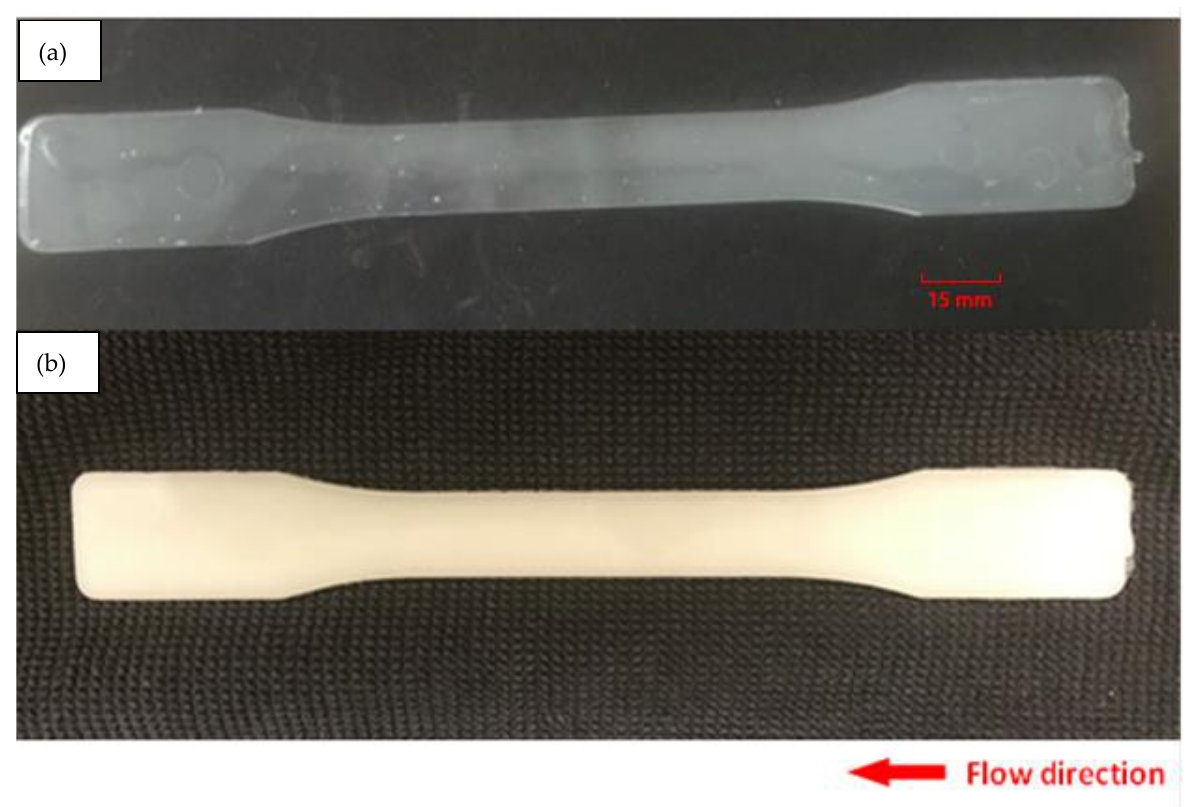
Figure 1. Injection molded sample: ( a ) neat PLA, ( b ) PLA-OA blend at 90 °C mold temperature.